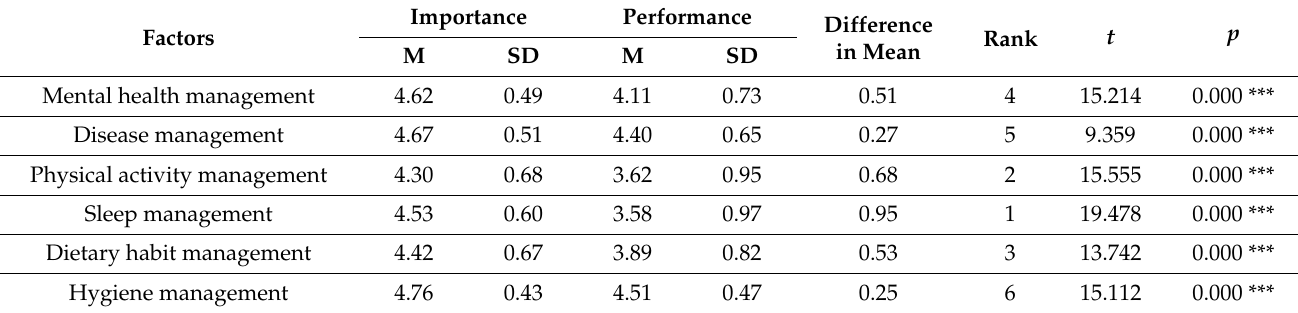
Table 3. Differences in the importance–performance of health awareness in K middle school students participating in the assignment-based online PE classes.